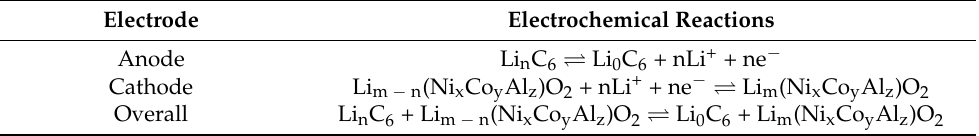
Table 4. Electrochemical reactions of a lithium nickel cobalt aluminum oxide (NCA)